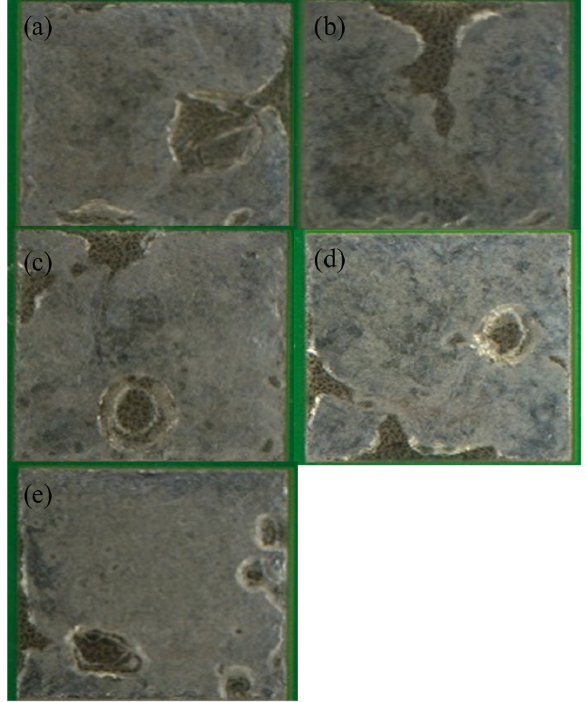
Figure 5. Optical images of LT 47 reflowed with ( a ) a peak temperature of 165 °C and 45 s TAL, ( b ) peak temperature of 165 °C and 90 s TAL, ( c ) peak temperature of 177 °C and 45 s TAL, ( d ) peak temperature of 177 °C and 90 s TAL and ( e ) peak temperature of 190 °C and 90 s TAL.